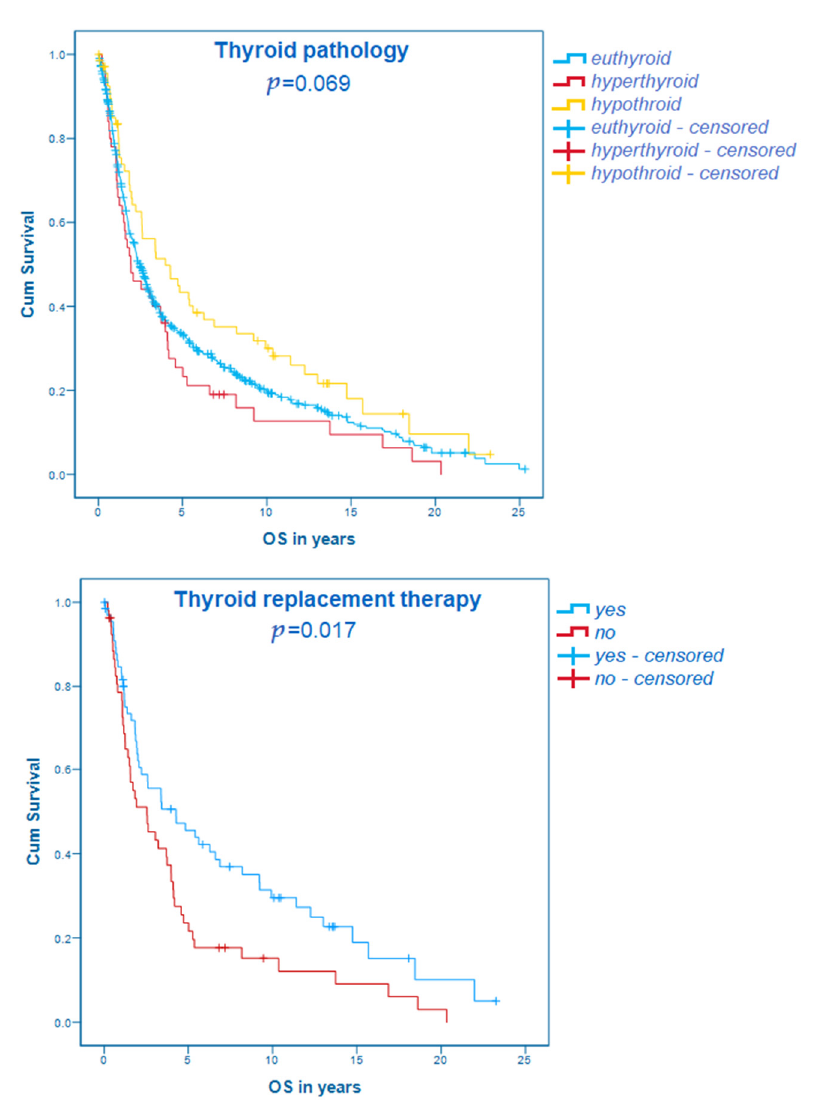
Figure 2. Kaplan–Meier curves concerning the thyroid hormone status as well as thyroid replacement therapy.